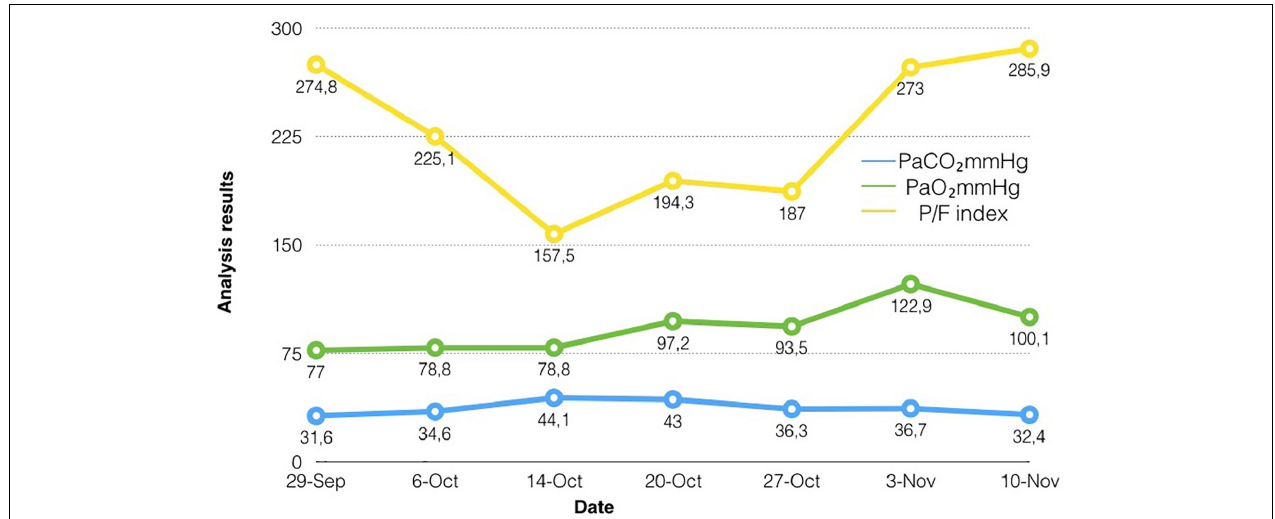
FIGURE 3 | The dynamics of the patient’s respiratory function